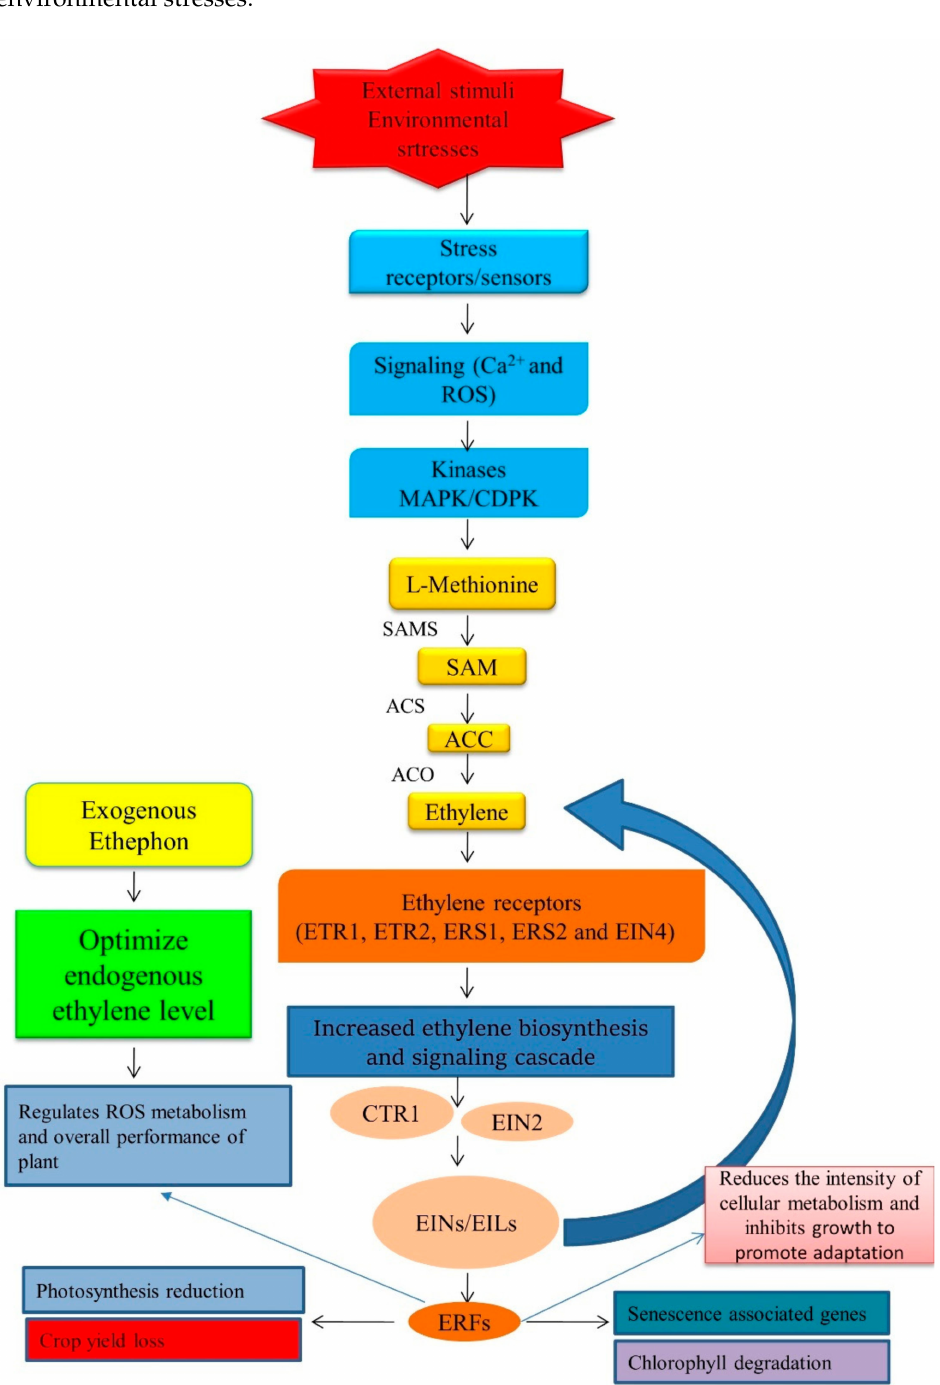
Figure 4. Regulation of ethylene biosynthesis and signaling for environmental stress acclimation. ACC, 1-aminocyclopropane-1-carboxylic acid; ACS, ACC synthase; CDPK, calcium-dependent protein kinase; Ca 2+ , calcium signaling; CTR1, CONSTITUTIVE TRIPLE RESPONSE1; SAM, S- adenosylmethionine; SAMS, SAM synthetase; ETR1, ETHYLENE RESPONSE1; ERS1, ETHYLENE RESPONSE SENSOR1; EIN4, ETHYLENE INSENSITIVE4; EIL, ETHYLENE INSENSITIVE3-LIKE 1; ERFs, ethylene-responsive factors; ROS, reactive oxygen species; MAPK, mitogen-activated pro- tein